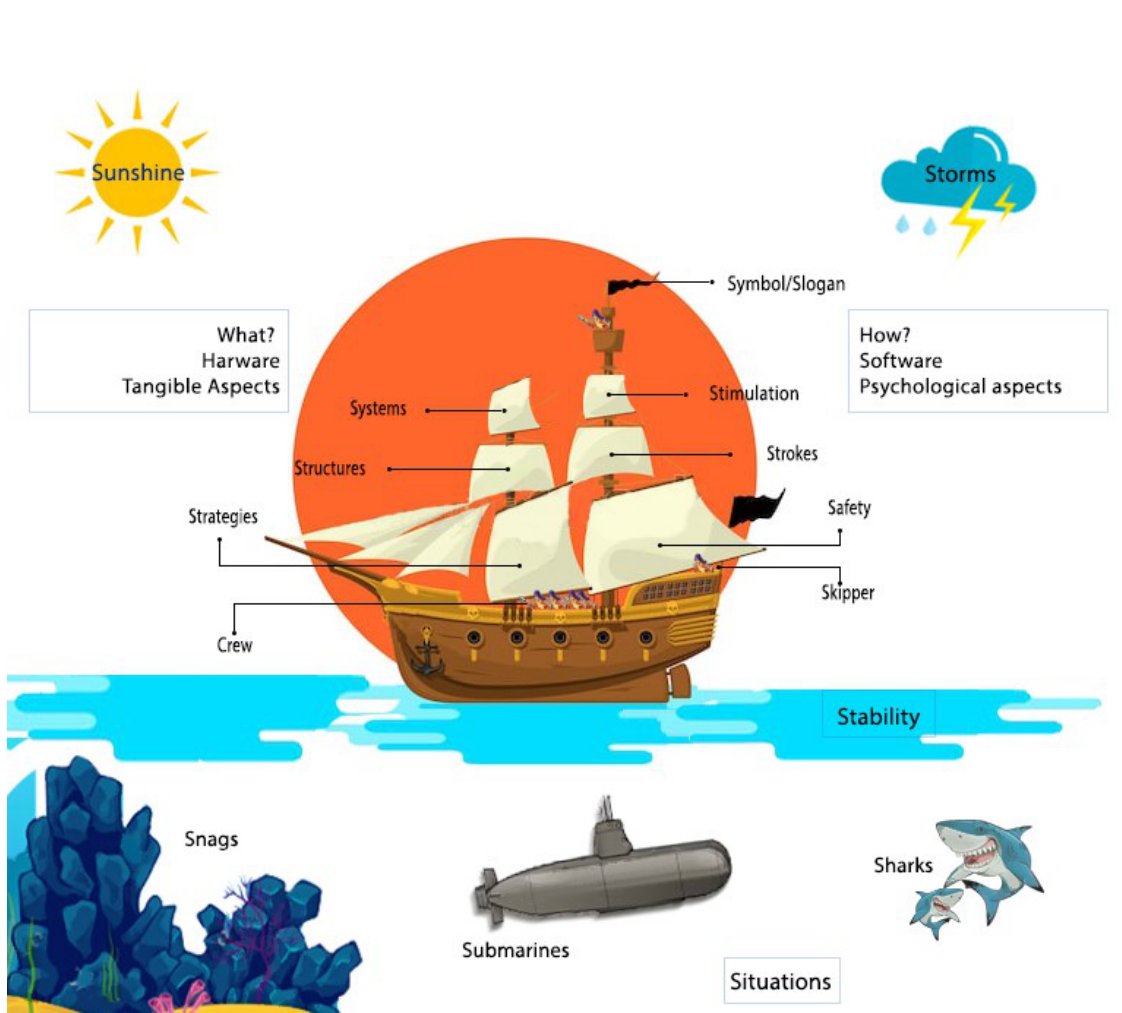
Figure 5: The Author's Visual Aid (amended from Hay, 2017,